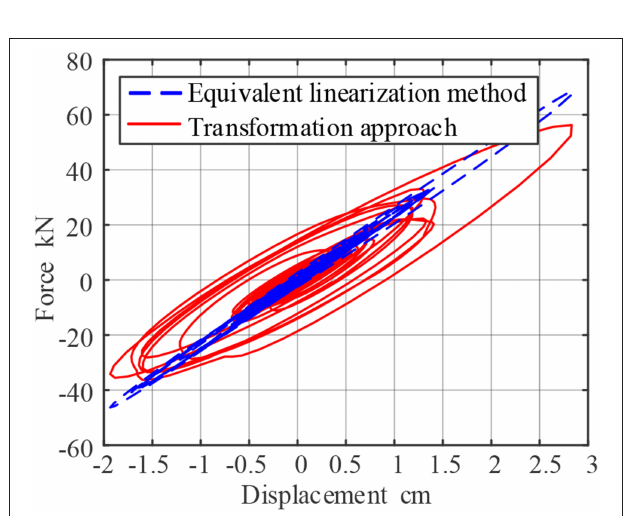
FIGURE 6 | Force-Displacement curve of viscoelastic resistance under seismic load (assuming working frequency 5Hz).